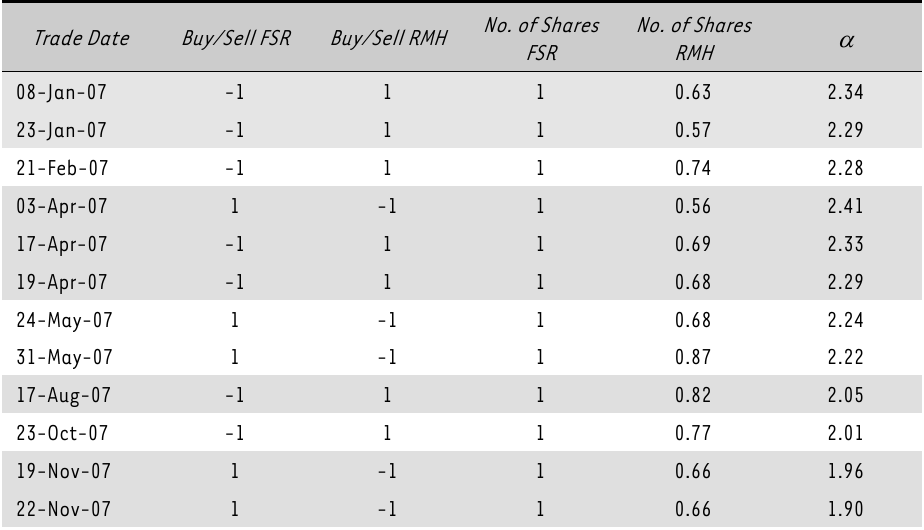
The pairs-trading opportunities identified from January 2007 to March 2009 for FSR and